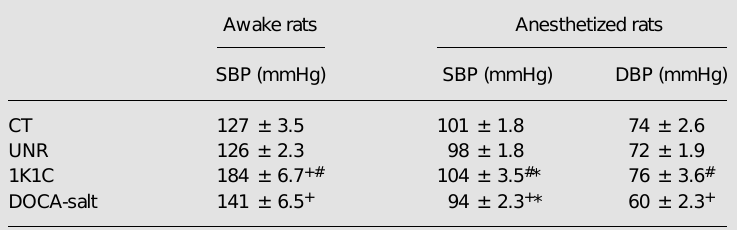
Figure 1. Time course of sys- tolic blood pressure (SBP) changes during 1-h treatment with 18 µg/kg ouabain in normo- tensive (control, CT; uninephrec- tomized, UNR) and hypertensive (1K1C and DOCA-salt) rats after anesthesia. Points represent the means ± SEM. *P<0.05 com- pared to before ouabain treat- ment (time zero) for all groups